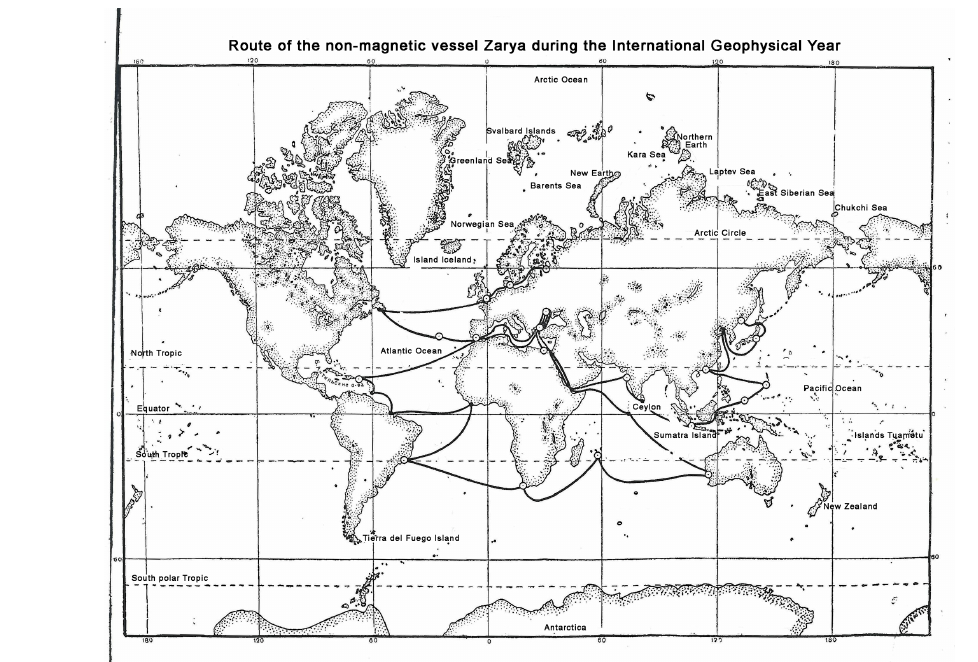
Figure 12. Route of the non-magnetic schooner Zarya during the IGY (Troitskaya, 1957).